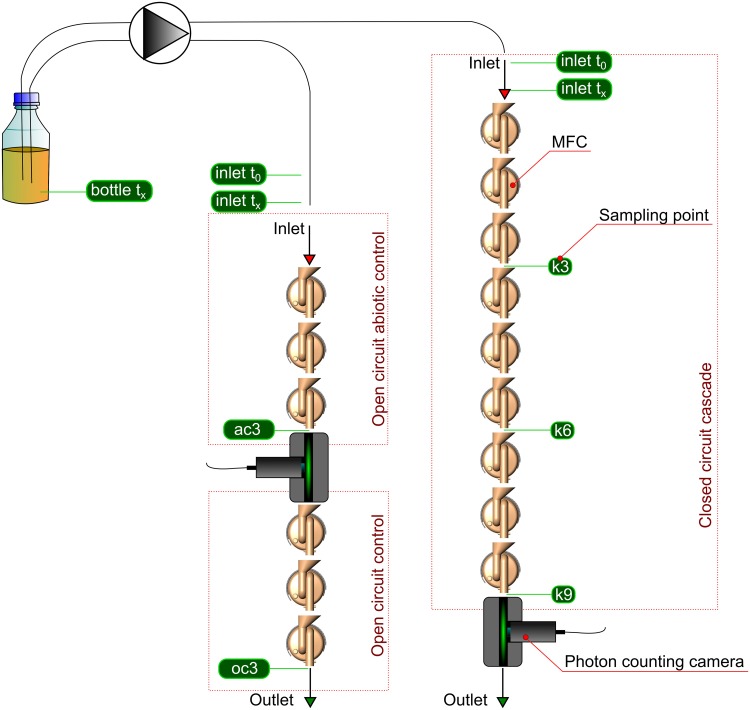
Schematic representation of the experimental setup.